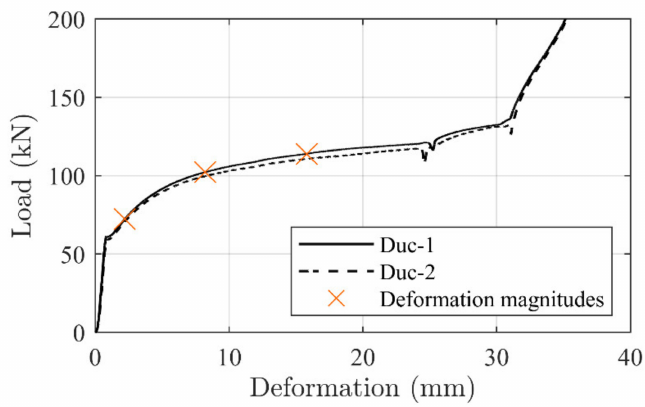
Figure 13. Typical complete ductile mechanism response versus ductile mechanism response in the beam PU1-2 for different stages (crosses in